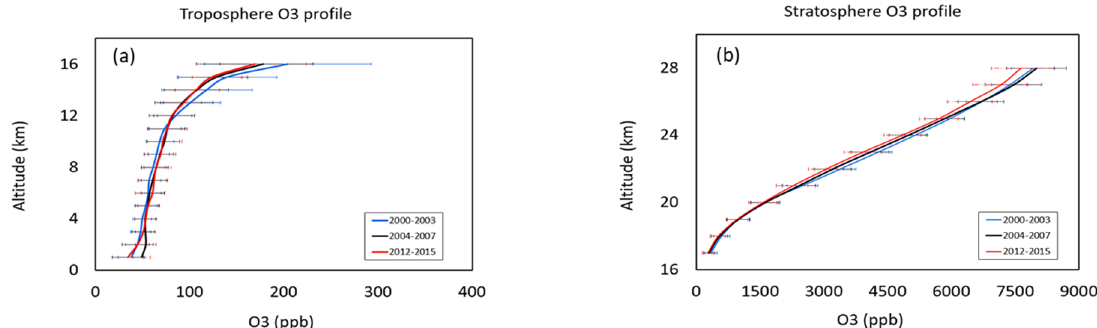
Figure 2. Ozone troposphere ( a ) and stratosphere ( b ) profiles. The blue line indicates 2000–2003 averages, black line indicates 2004–2007 averages and red line indicates 2012–2015 averages. The error bars indicate the standard deviation.